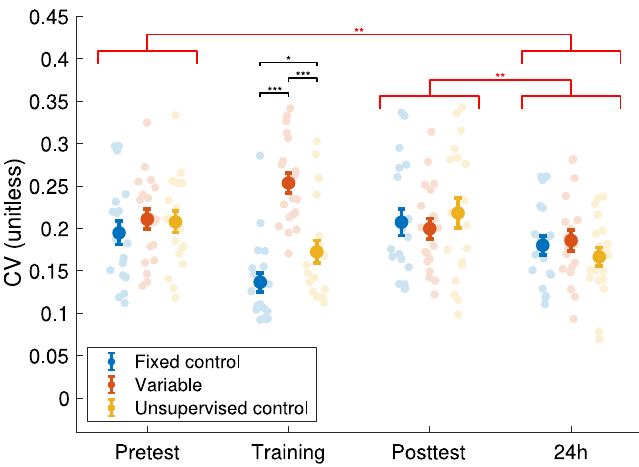
Figure 2. Coefficient of variation (CV) for movement timing variability between touching the thumb and the other finger, for the three groups, averaged across movements in the different blocks. The faint circles are data for all subjects, dark dots are the mean, error bars are the standard error for each group. The black bars indicate significant between-group differences, the red bars indicate significant differences between sessions. *p ≤ 0.05, **p ≤ 0.01, ***p ≤ 0.001. N = 19 for all